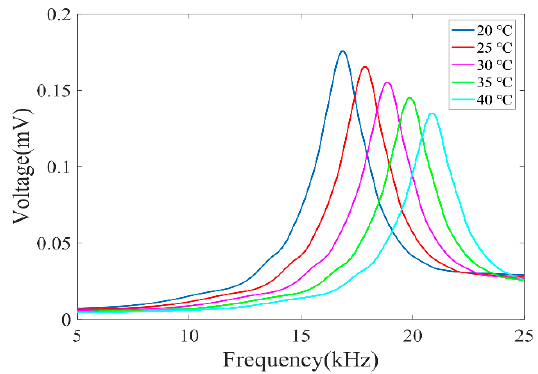
Figure 5. Measured amplitude-frequency response of the PA microcavity gas sensor filled with 1000 ppm CH 4 /N 2 gas mixture under different temperatures.